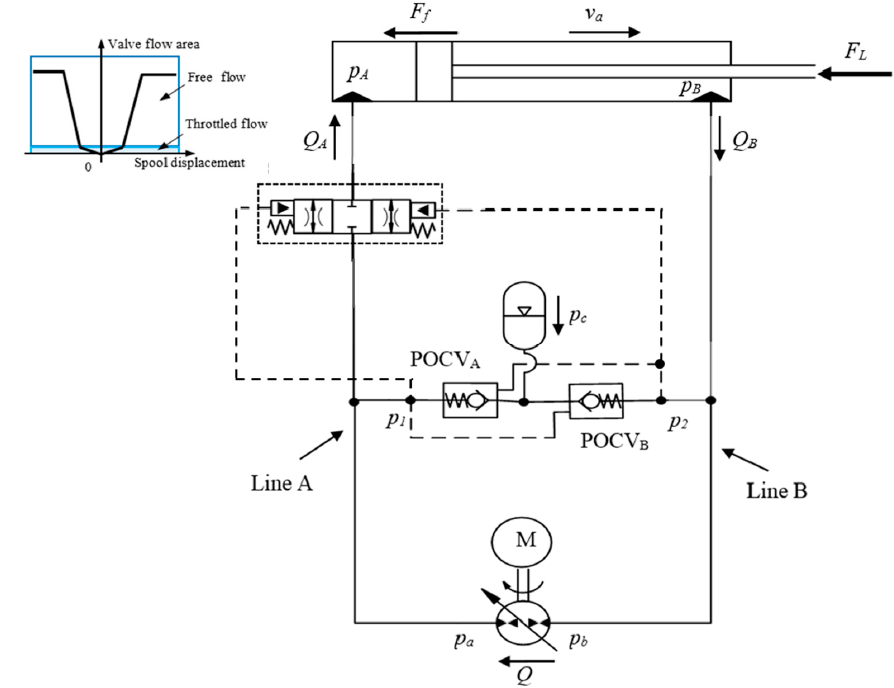
Figure 7. Proposed circuit incorporating a special valve.